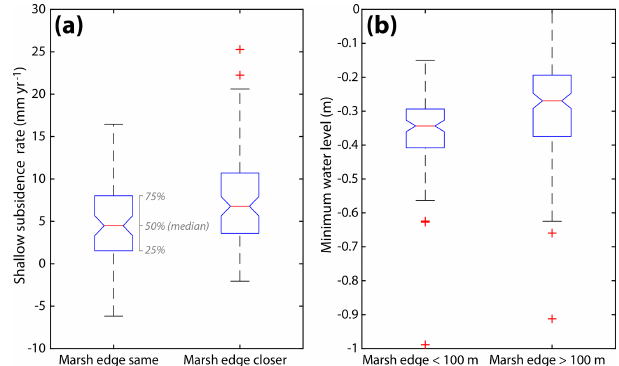
Figure 5. (a) Distribution of shallow subsidence rates for locations where a shipping canal has (not) reduced the distance to the marsh edge. (b) Distribution of minimum water level for sites within and outside of 100m from the marsh edge.